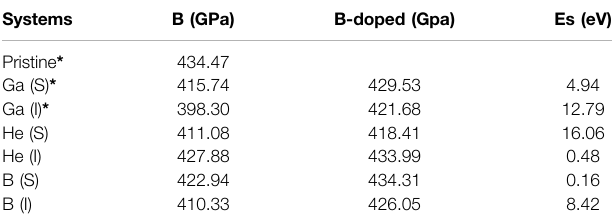
TABLE 1 | The bulk modulus and strain energies of pristine and doped diamond materials. IandSareshortforinterstitialand substitutionalpositions.{*labeled results based on the previous theoretical work [Lee et al. (2019)]}.